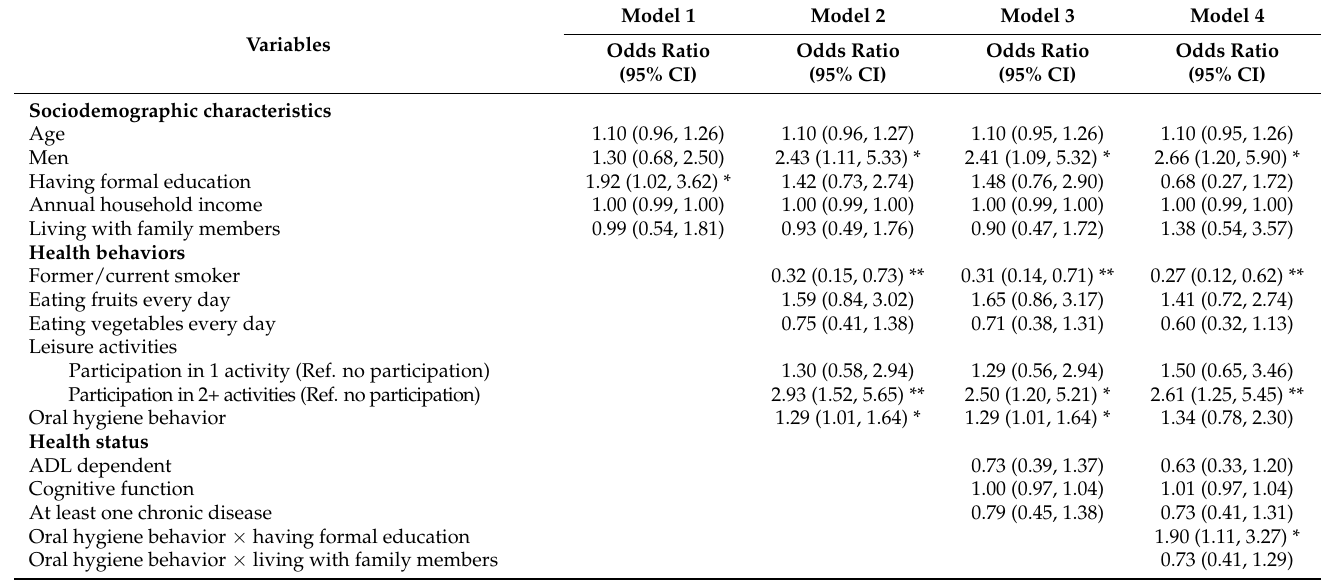
Table 2. Ordinal logistic regression results for self-reported oral health status among longevous persons ( n = 185). Model 1 Model 2 Model Variables